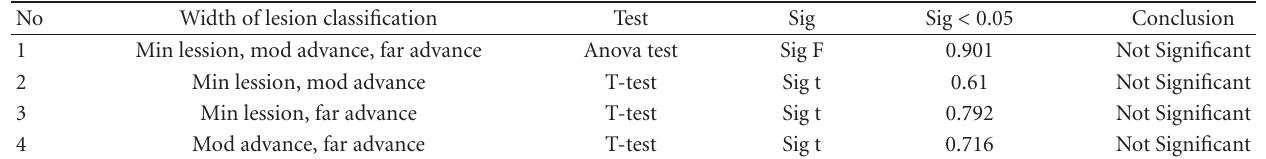
Table 3: Result of ANOVA